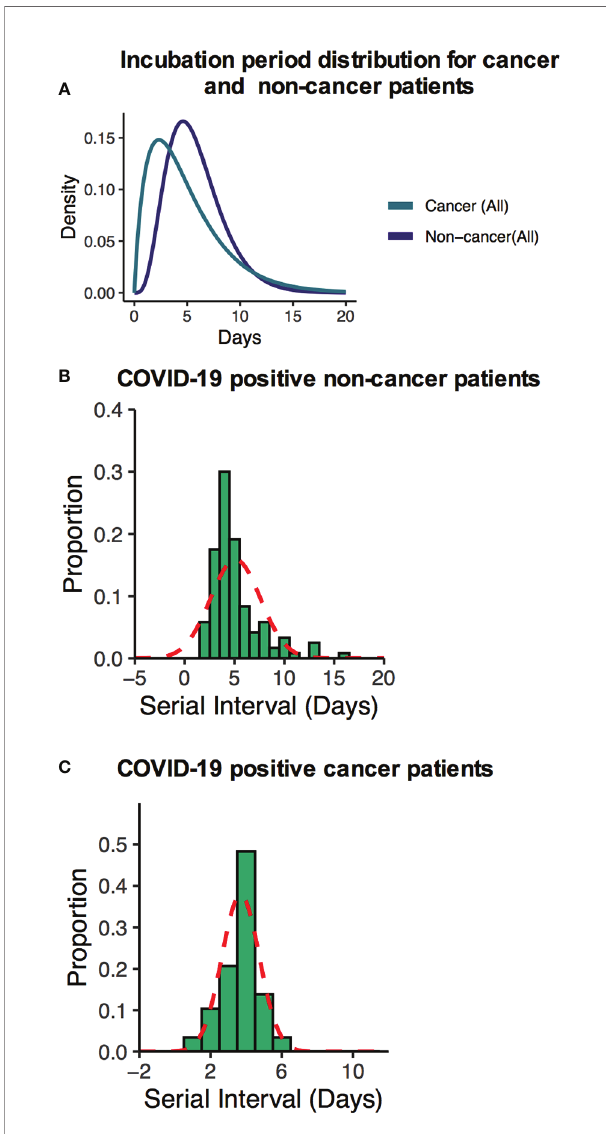
FIGURE 3 | (A) Fitted gamma COVID-19 incubation period distributions for all non-cancer and cancer cases including cancer speci fi c cases. (B, C) Serial interval distribution of COVID-19 infection cases among cancer and non- cancer